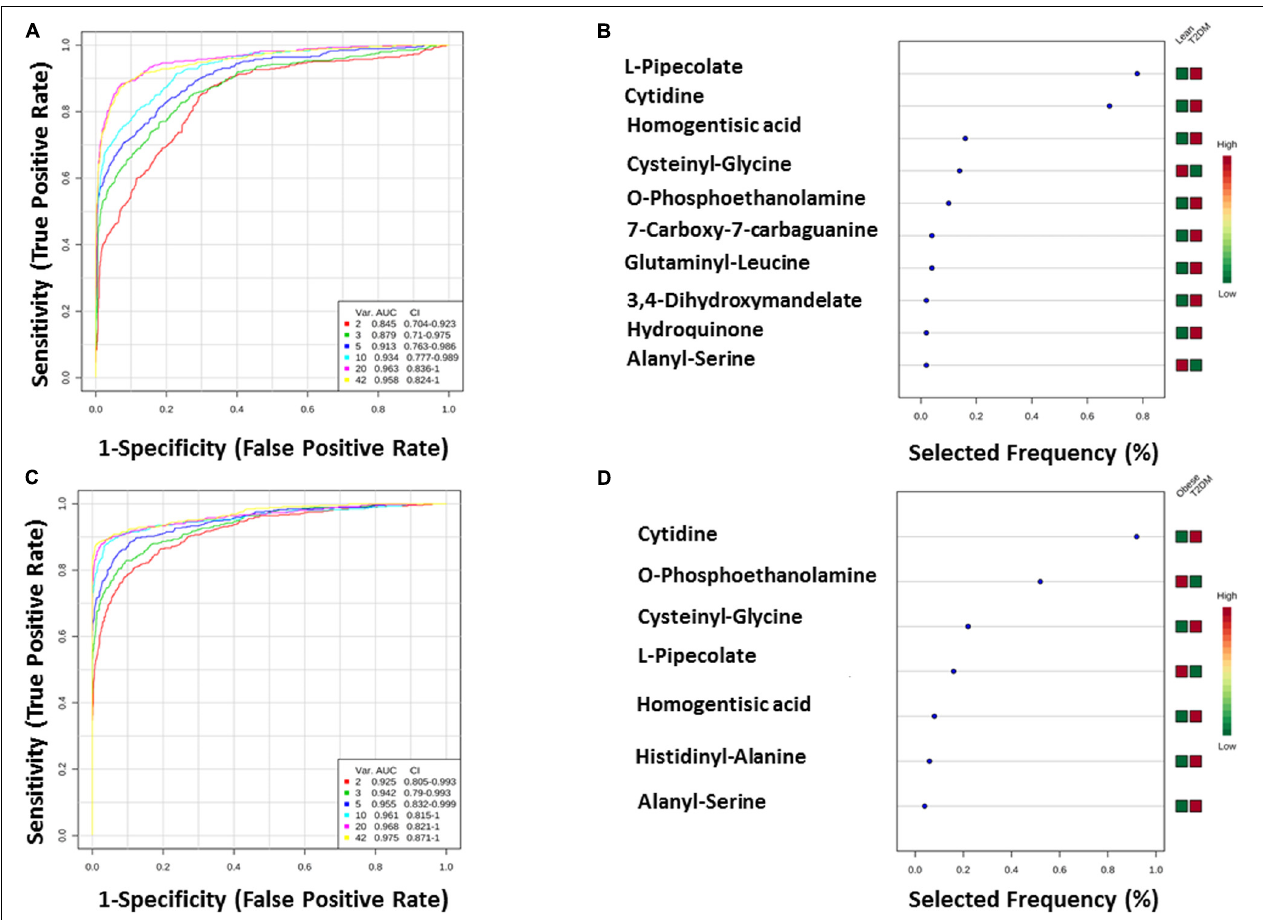
FIGURE 7 | (A,B) Lean vs T2DM ROC analysis for T2DM top 10 metabolites. (C,D) Obese vs